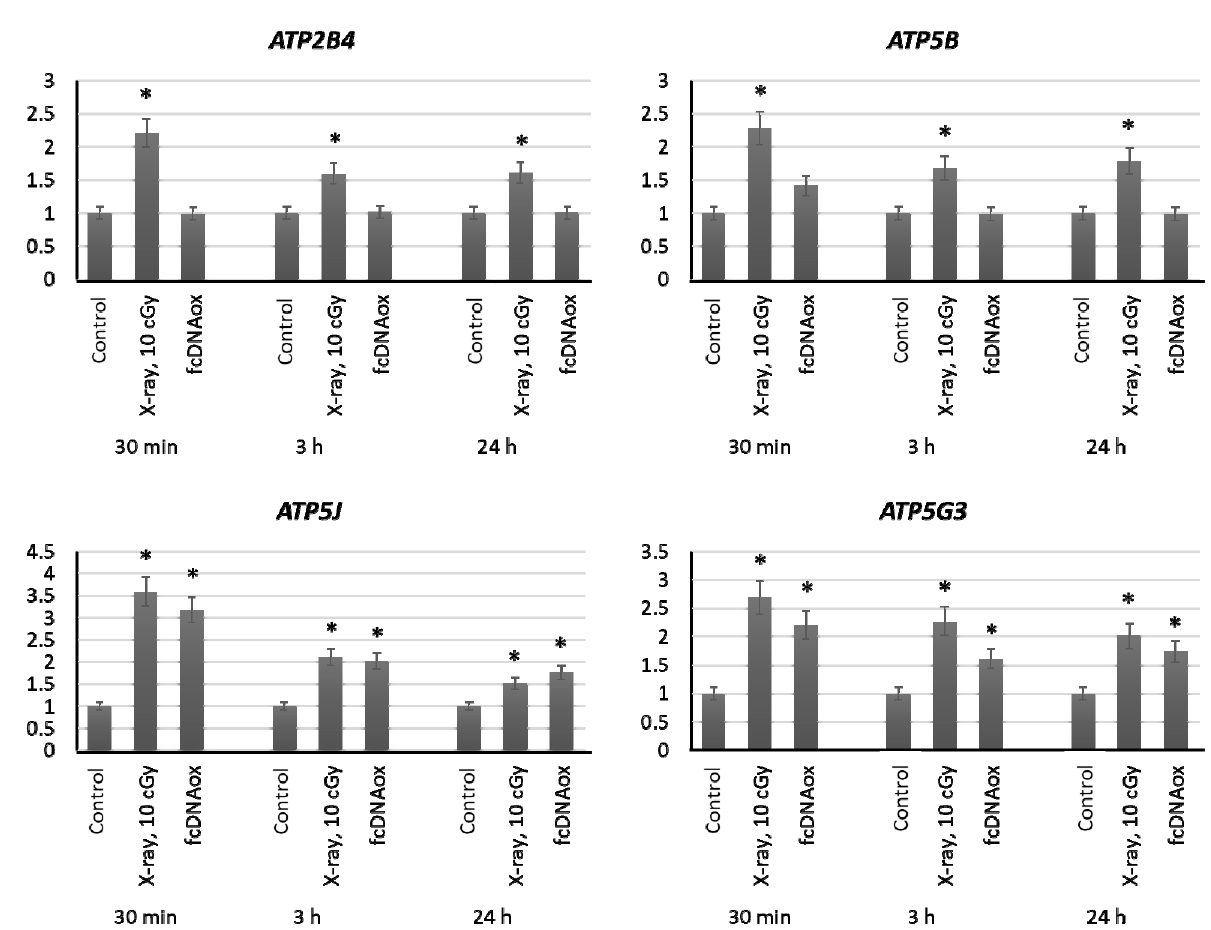
Figure 6. The expression of genes of the mitochondrial respiratory Complex V influenced by low-dose radiation (10 cGy) and oxidized cfDNA (50 ng/mL) assessed by real-time PCR. The genes are indicated in the figure. Ratios to control values are presented. The TBP gene was used as an internal standard gene. Mean values were calculated from five independent measurements; (*) denotes a significant difference from control experiments, p < 0.001, nonparametric U-test.